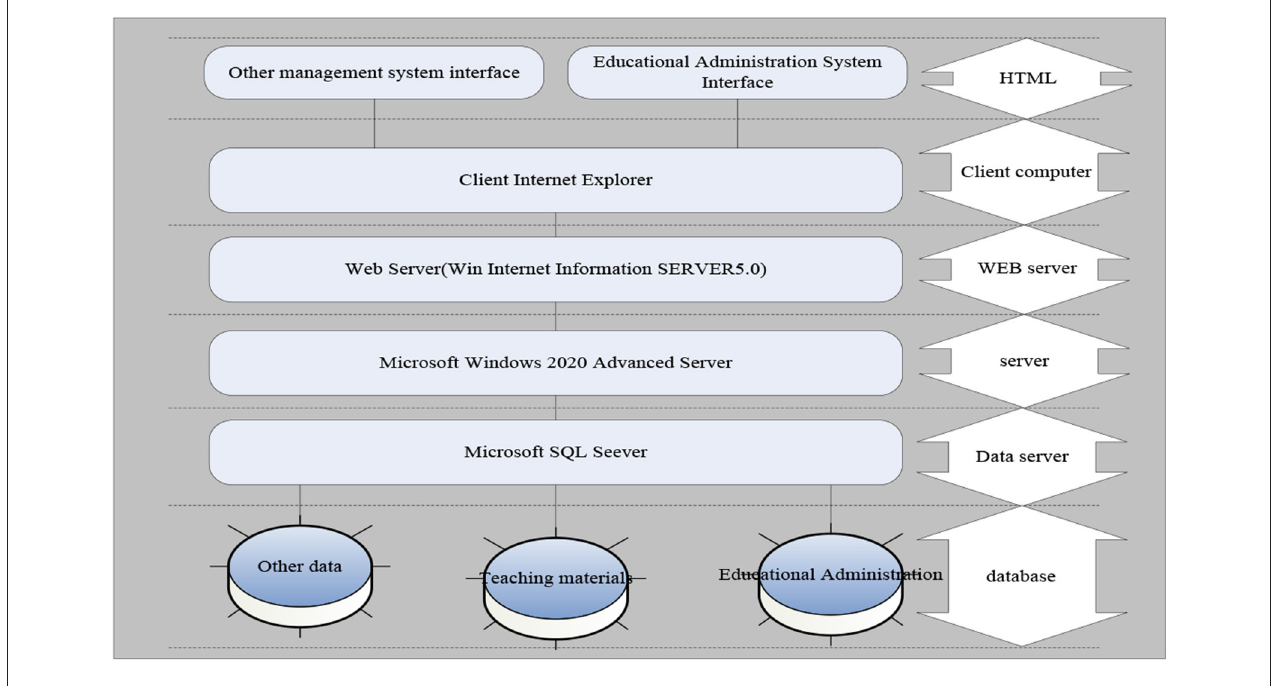
FIGURE 4 | The overall structure of the logic of the